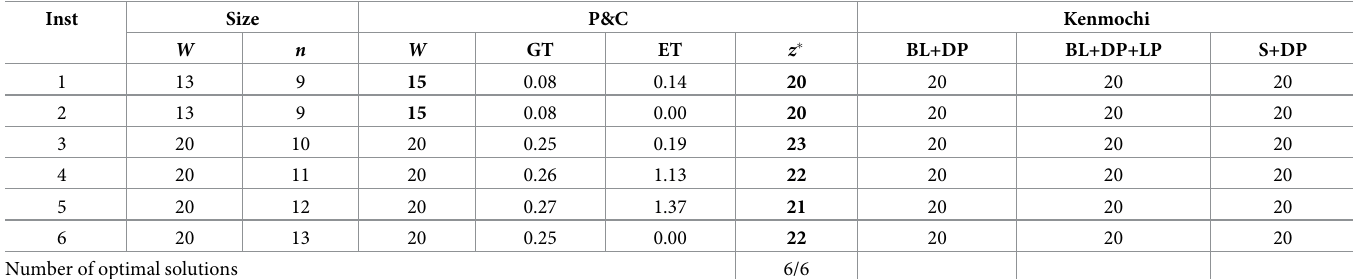
Table 10. Results for kenmochi